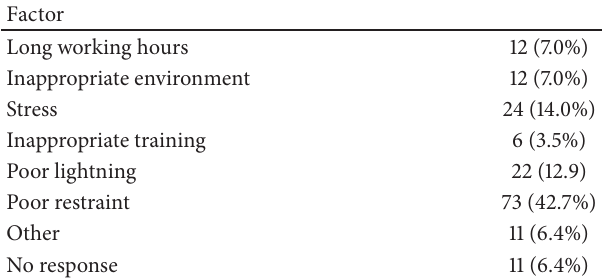
Table 4: Reasons for needlestick injury ( 𝑛 = 171 ).